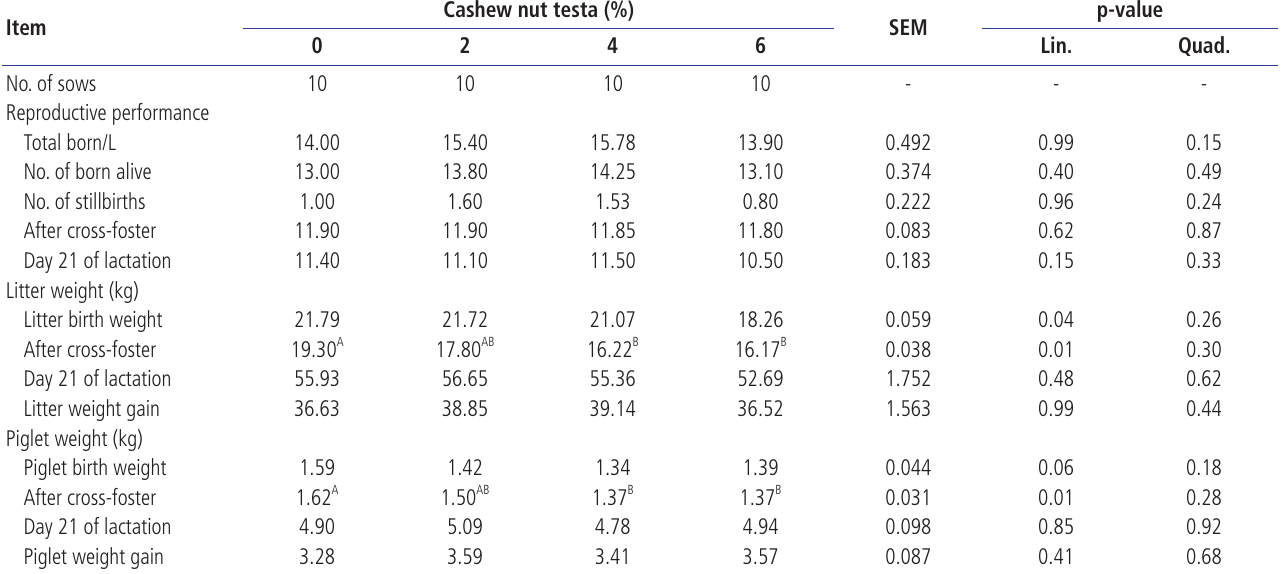
Table 6. Effects of cashew nut testa level on reproductive and litter performance in gestating to lactating sows Item